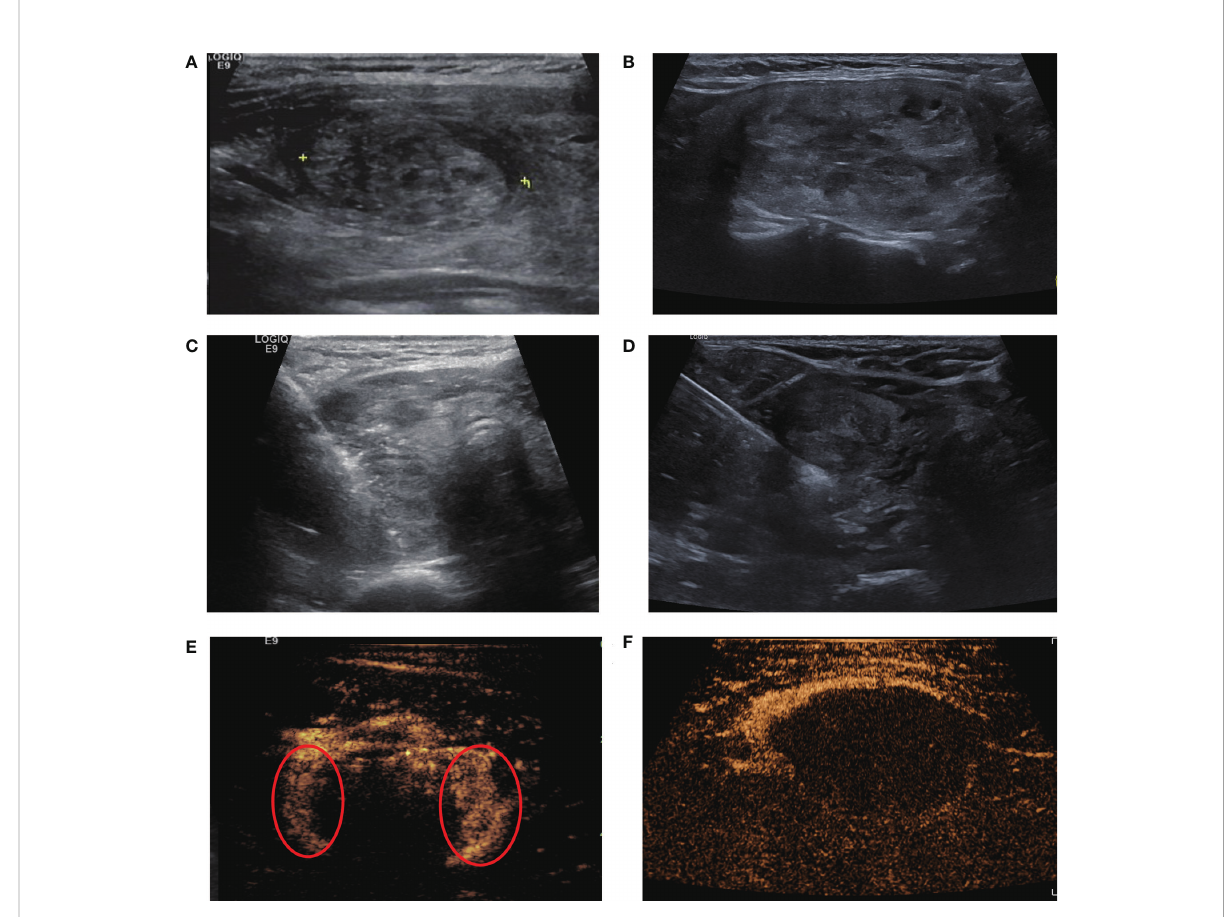
FIGURE 4 Single-session radiofrequency ablations of benign thyroid nodules using one insertion point with a fan-shaped overlapping mode (A, C, E) and multiple insertion points with a novel parallel overlapping mode (B, D, F) . (A, B) A 40-year-old female and A 46-year-old female A both had a predominantly solid nodule in the left lobe of the thyroid. Ultrasound examination showed the baseline volume of the nodule was 8ml, 14ml and the craniocaudal diameter was 3.0cm, 4.2cm, respectively. RFA was performed using one insertion point with a fan-shaped mode (C) or multiple insertion points with a novel parallel overlapping mode (D) . (E) Contrast-enhanced ultrasound after initial RFA using one insertion point with a fan-shaped mode: some tissue showed enhancement within the nodule, indicating residual tissue (circle). (F) The nodule using multiple insertion points with a novel parallel overlapping mode after initial RFA showed non-enhancement within the nodule, which meant that this mode could achieve complete ablation more